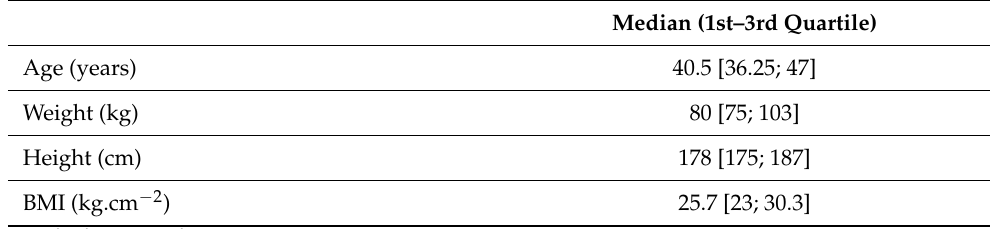
Table 1. Participants’ anthropometric parameters ( n = 8).